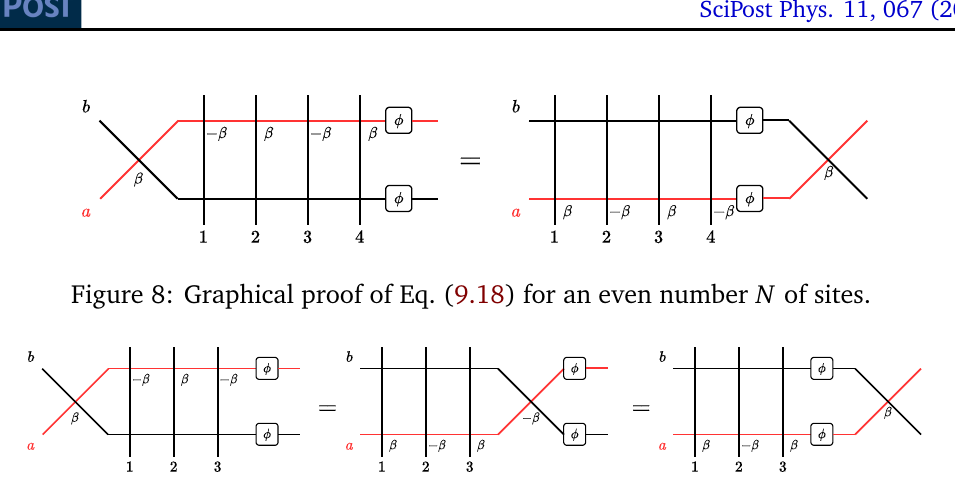
Figure 9: Graphical proof of Eq. (9.18) for an odd number N of